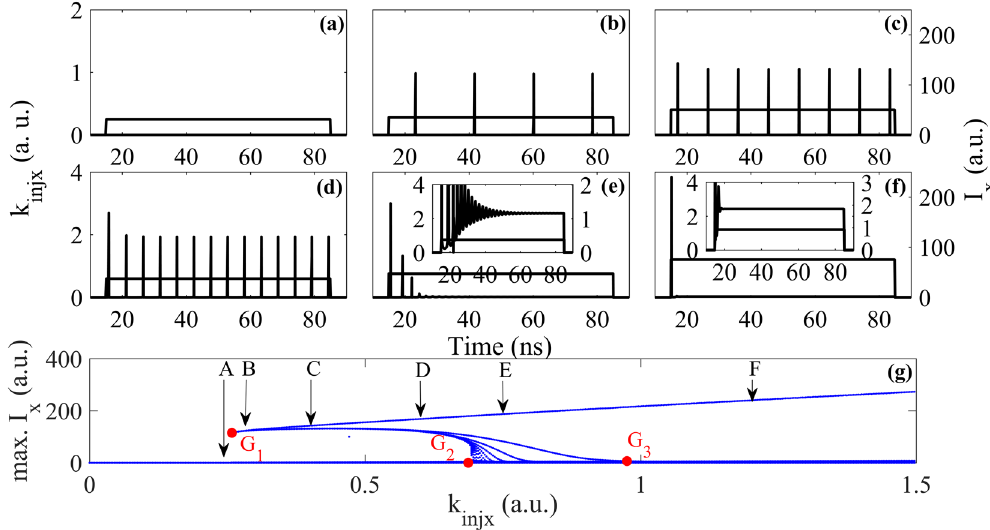
Figure 3. The responses of VCSEL-SA to EIOP subject XP mode ( a )–( f ) and the numerical bifurcation diagram of XP mode as a function of k injx ( g ). ( a )–( f ) with k injx = 0.25, 0.28, 0.4, 0.6, 0.75, 1.2. The enlargements of the generated spikes of ( e ),( f ) are plotted in the